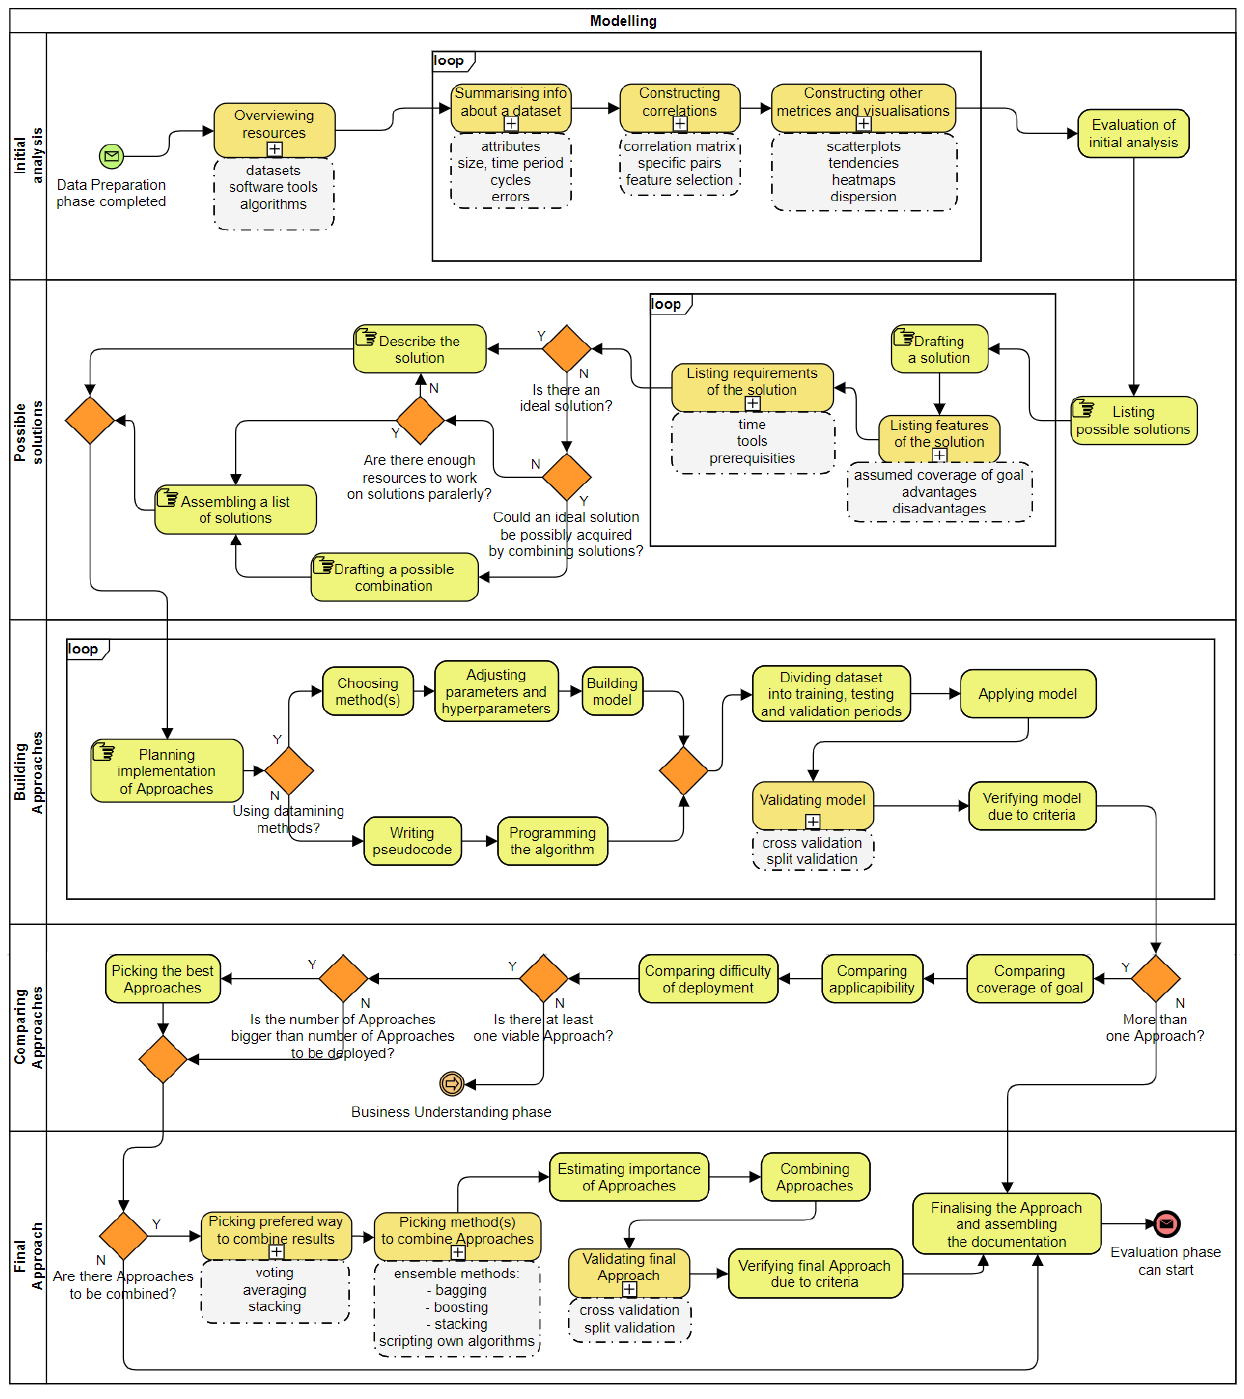
Figure 4. Detailed diagram proposal for the ‘Modelling’ phase.